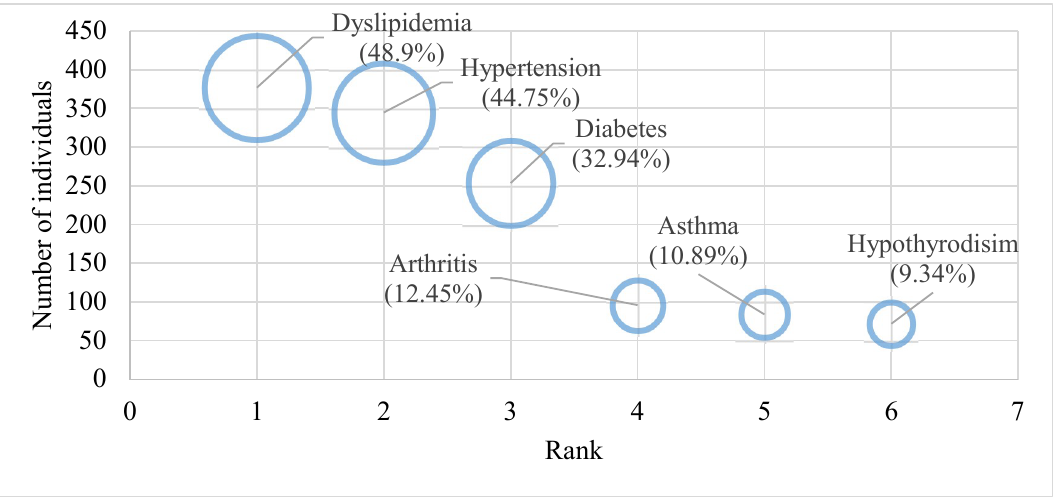
Figure 1. Distribution of individuals by NCDs and rank order in the sample. Table 1. The surveyed individuals with NCD’ characteristics (N = 771).